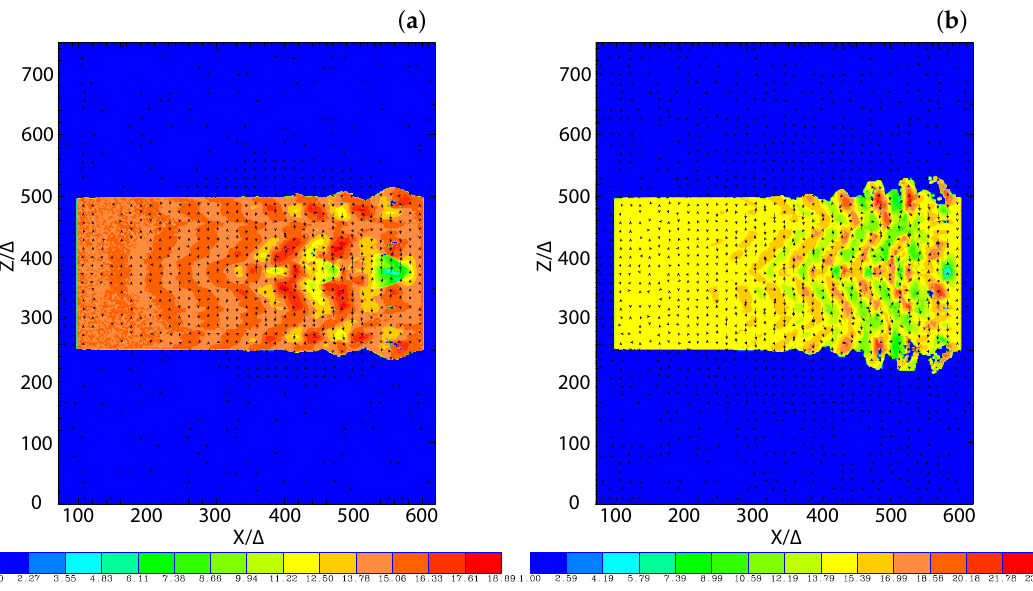
Figure 8. Panels ( a , b ) show the 2D plot of the Lorentz factor of jet electrons for e − − p + ( a ) and e ± ( b ) jet with r jet = 120 ∆ at time t = 500 ω − 1 pe . The arrows (black spots) show the magnetic fields in the x − z plane. Adapted from Figure 3 in Nishikawa et al. [62].